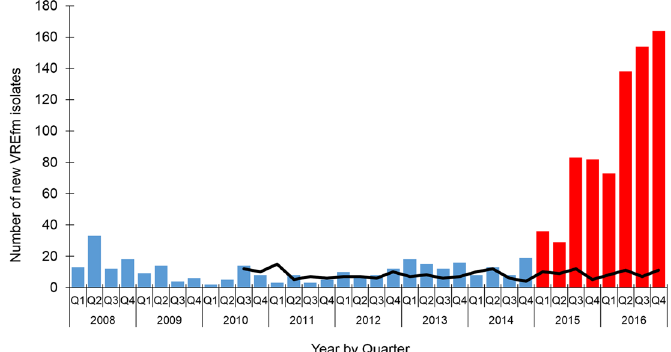
Figure 1. Number of newly identified vancomycin-resistant enterococcal (VRE) isolates (clinical and/or screening) in Tasmanian healthcare settings, 2008–2016. The number of new VRE isolates reported from Q1, 2008 to Q4, 2016 (columns). Since Q1, 2015, a marked increase in VRE isolates is indicated (red columns). The number of healthcare-associated Staphylococcus aureus bacteraemia cases (HA-SAB) is shown for comparison (black